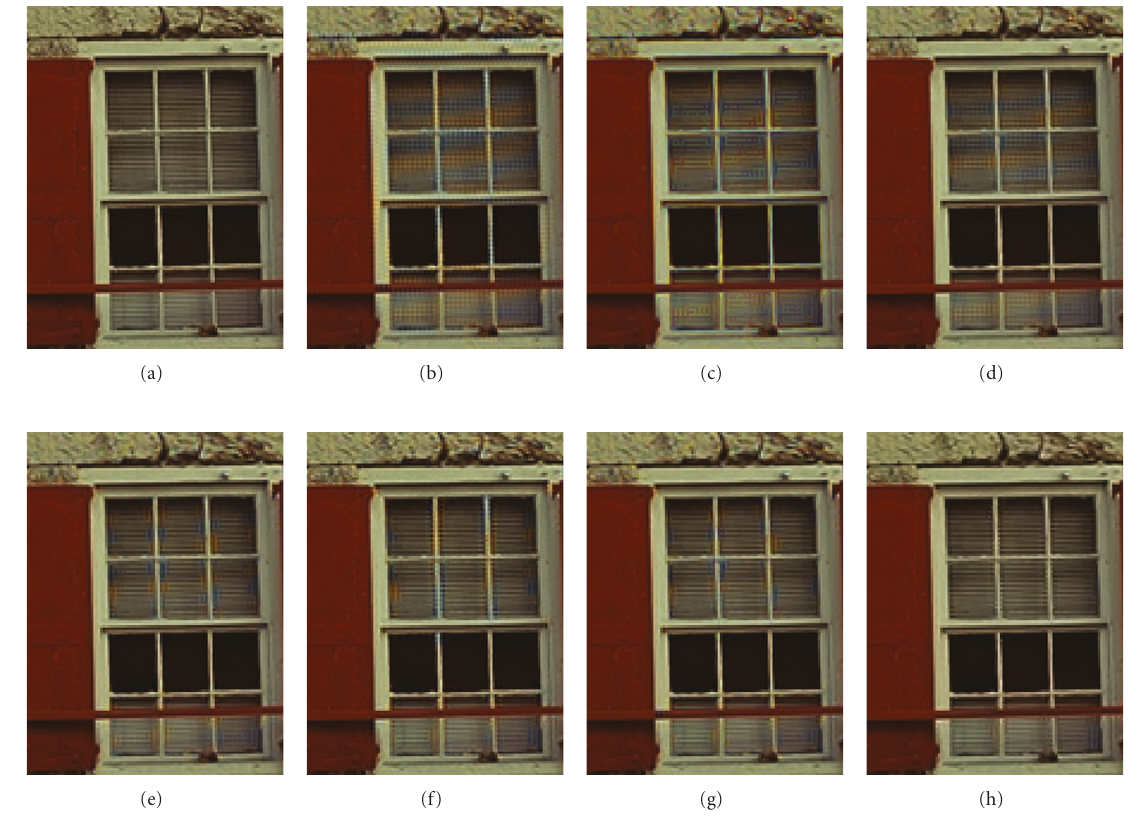
Figure 12: Partially magnified Kodak 1 image: (a) original image, (b) method discussed in [7], (c) method discussed in [10], (d) method discussed in [15], (e) method discussed in [22], (f) method discussed in [24], (g) method discussed in [27], and (h) Proposed method.